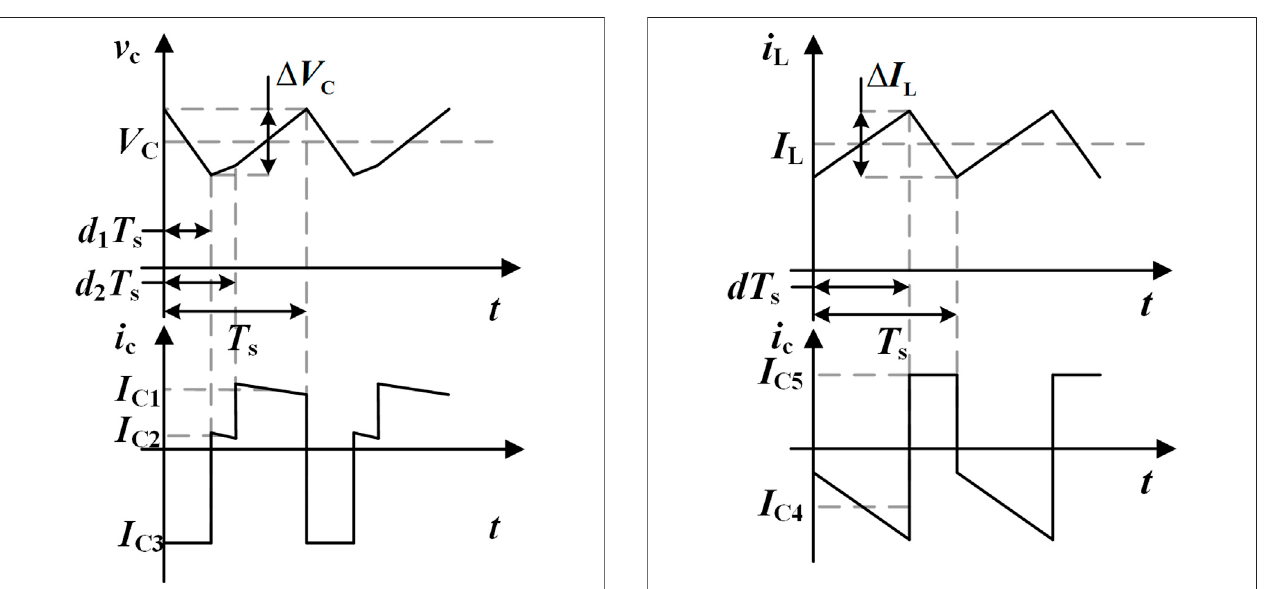
FIGURE 15 | Central capacitor voltage and current in the TICC converter.